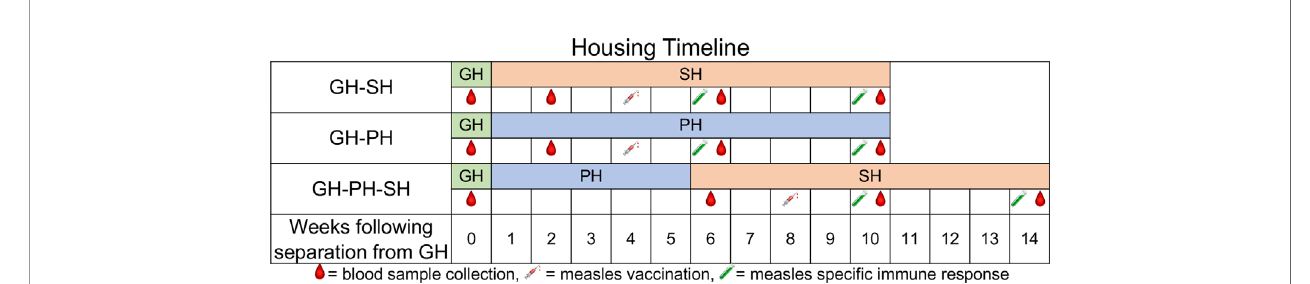
FIGURE 1 | Housing conditions and measles vaccination schedule for treatment groups over the duration of the study are shown. The housing conditions include GH-SH (group housed to single housed), GH-PH (group housed to paired housed), and GH-PH-SH (paired housed to single housed) along-with the sample collection timepoints for each group. All animals were group-housed prior to initiation of the study. Two and six weeks post-vaccination time points were used for measuring antigen speci fi c T cell responses and measles speci fi c neutralizing antibody titers